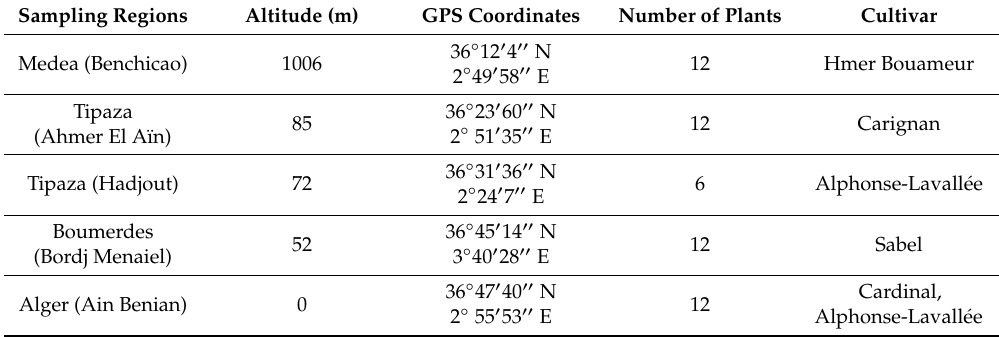
Table 1. List of Algerian regions for grapevine sampling and the number of sampled grapevines. Sampling